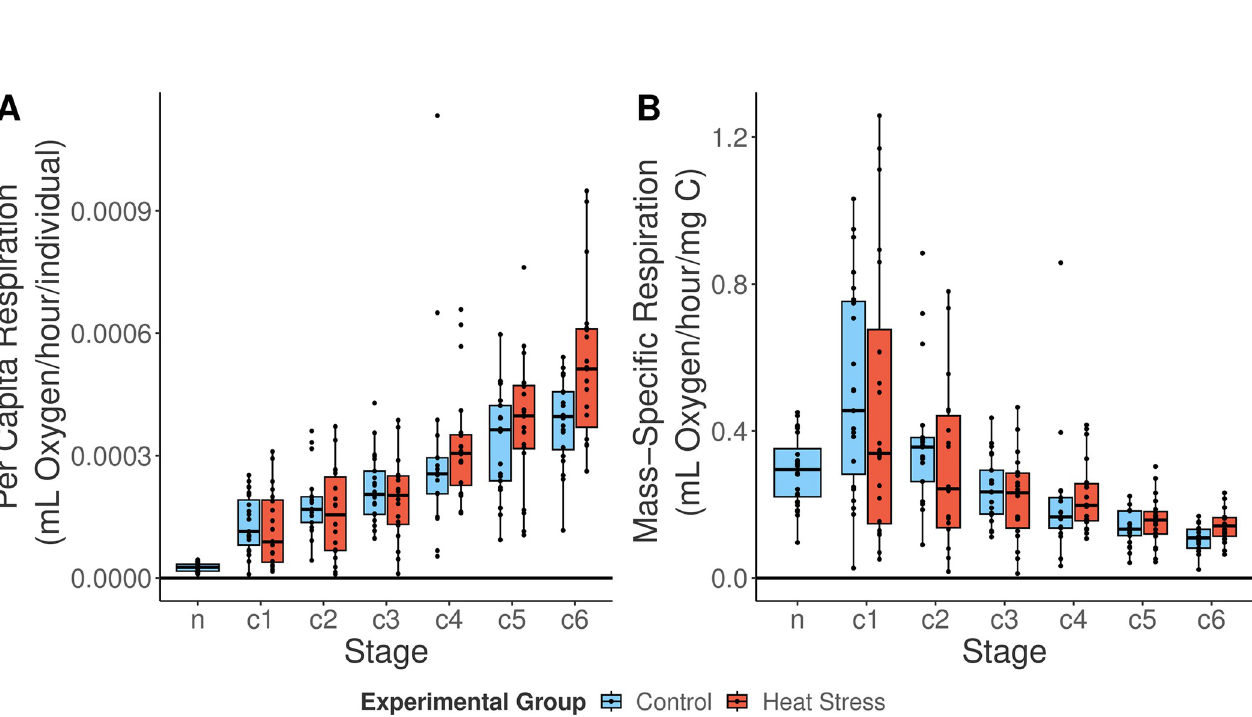
Fig 3. Per capita and mass-specific respiration rates of Acartia tonsa . (A) Per capita respiration rates (mL O2/hour/ind.) of pooled nauplii (n) and individual copepodite stages (C1-C6). (B) Mass-specific respiration rates (mL O2/hour/mg carbon) of pooled nauplii and copepodite stages. Different treatments are indicated by different fill colors. Individual respiration rate measurements are shown as individual points. Boxplot components as describes in Fig 1B.